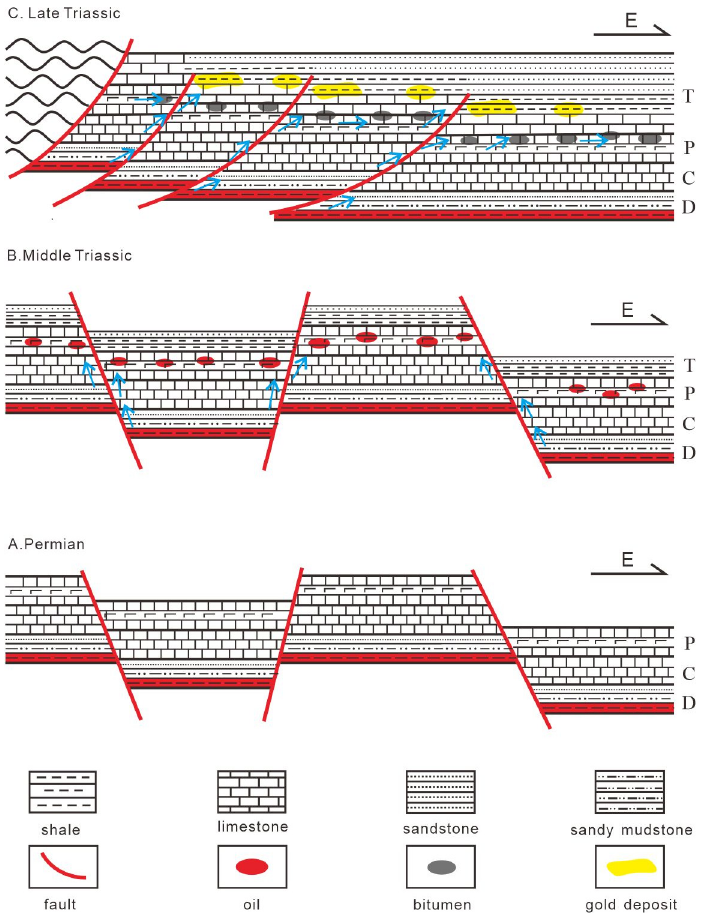
Figure 12. Simplified model for the petroleum evolution and gold mineralization in the Nanpanjiang-Youjiang Basin.